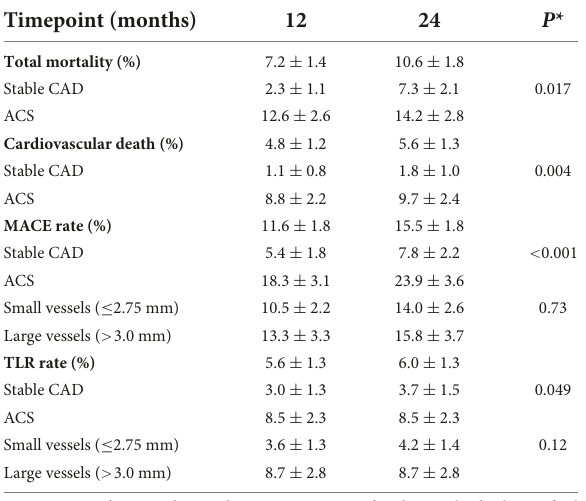
TABLE 4 The primary endpoints of the study at 12 and 24 months.